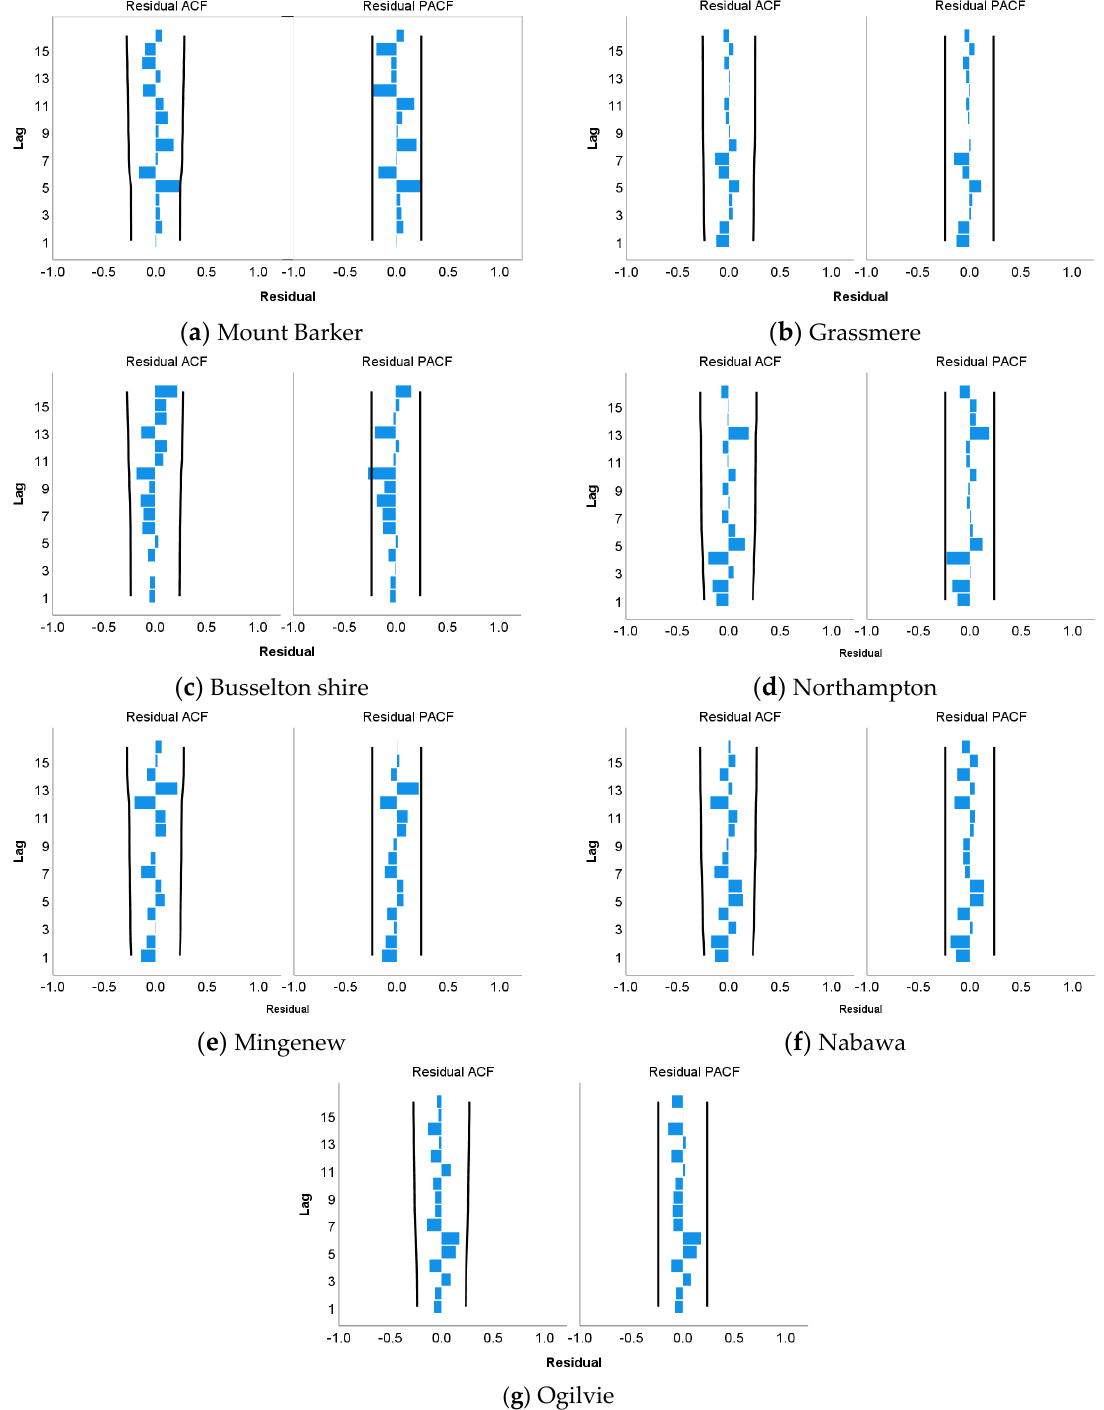
Figure A2. Residual ACF and PACF plot for ( a ) Mount Barker; ( b ) Grassmere; ( c ) Busselton Shire; ( d ) Northampton; ( e ) Mingenew; ( f ) Nabawa; ( g ) Ogilvie.